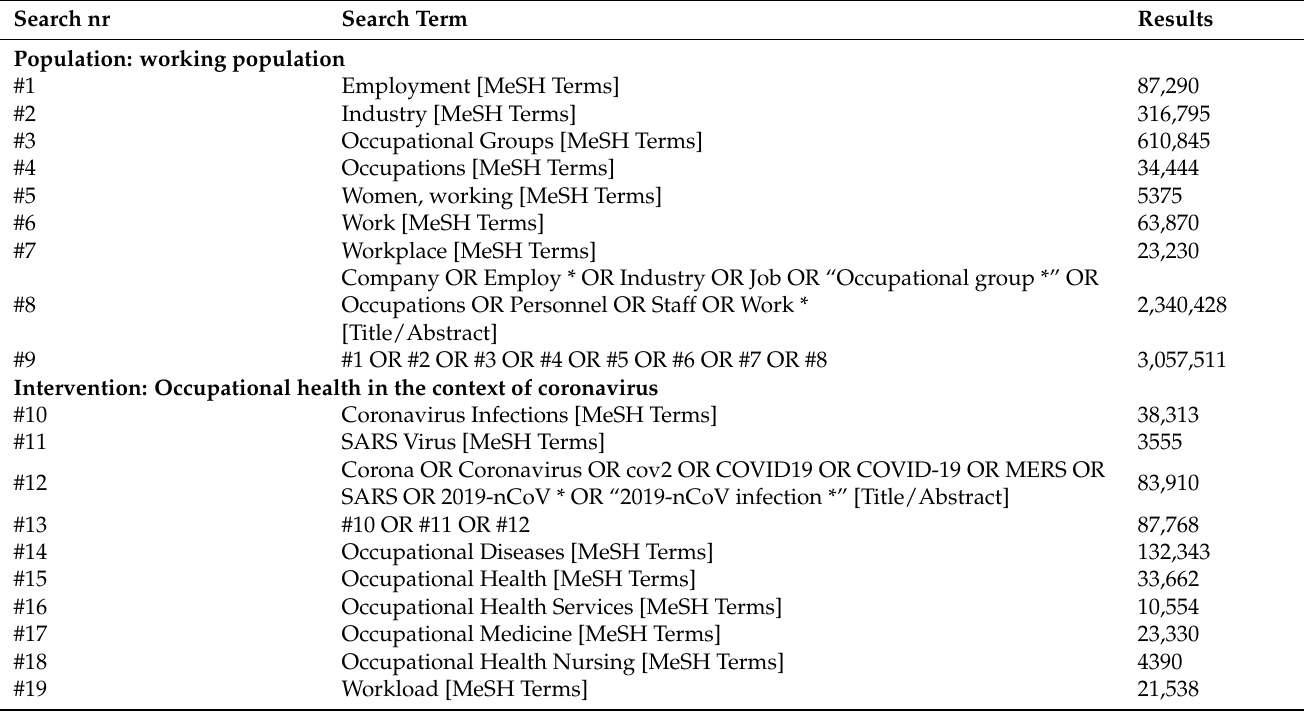
Table A3. Database: Pubmed (via NCBI) Date: